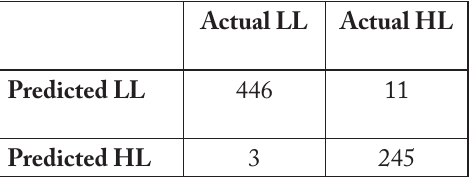
Table 9: Confusion